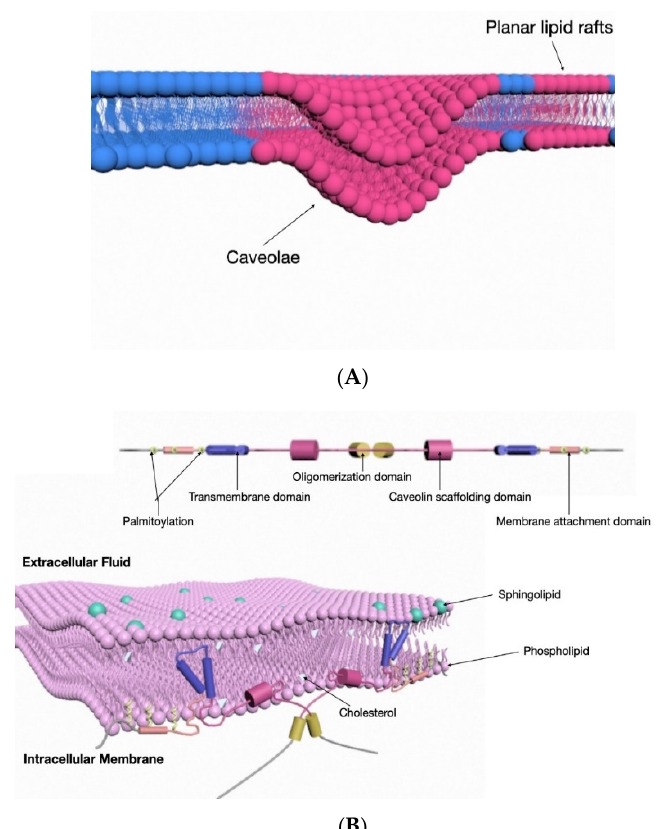
Figure 2. ( A ) Schematic illustration of caveolae and planar lipid rafts on the cell membranes. ( B ) Schematic diagram of caveolin-1 primary structure and predicted topology. Schematic showing that cav-1 is an integral membrane protein. The primary structure and predicted topology is illustrated here. Cav-1 often self-associates to a homo-oligomer which is called a caveolar assembly unit. Each caveolar assembly unit is composed of 14–16 monomers. Here, we show a dimer of cav-1 formed by two cav-1 monomers via the oligomerization domain (yellow color). The amino- and carboxyl-ends face towards the cytosol side. A hairpin loop (transmembrane domain, blue color) inserts into the membrane bilayer. The amino-terminal membrane-attachment domain is the caveolin scaffolding domain (CSD) (violet color).